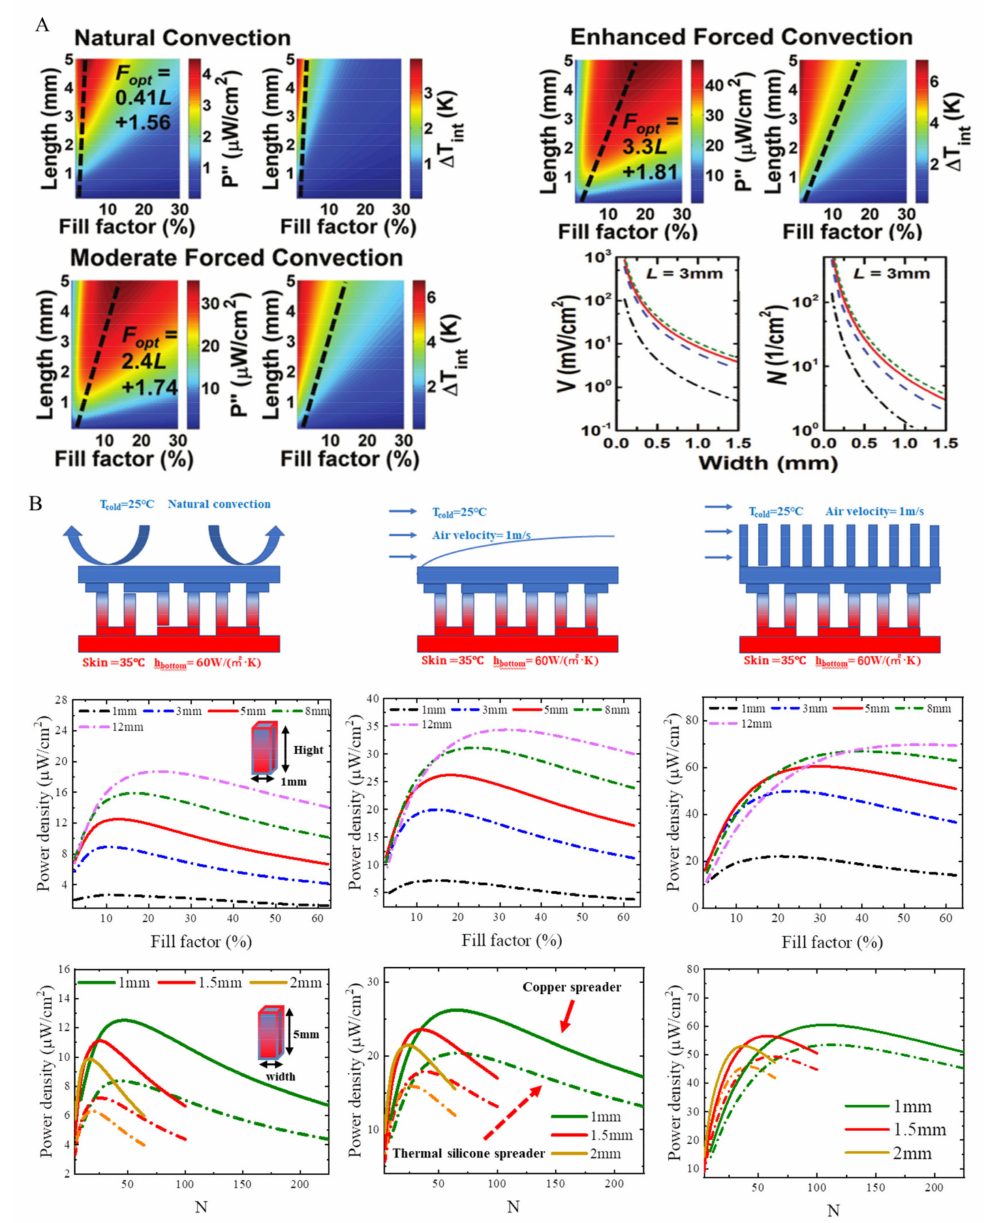
Figure 7. ( A ) Results of TE geometric parameters obtained by numerical analysis [37]. ( B ) Results of TE geometric parameters obtained by Finite Element Simulation